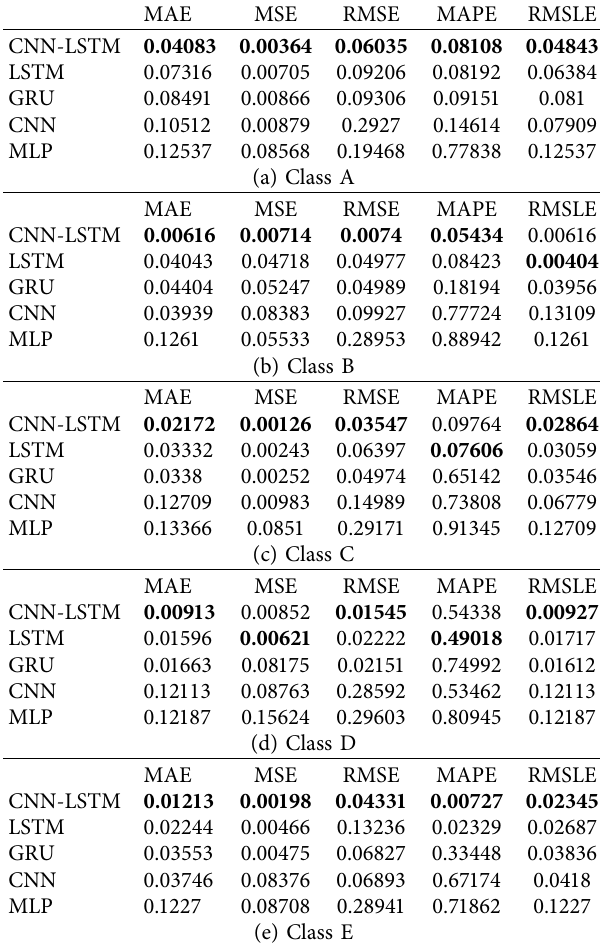
Table 7: Deep learning for univariate time series evaluation